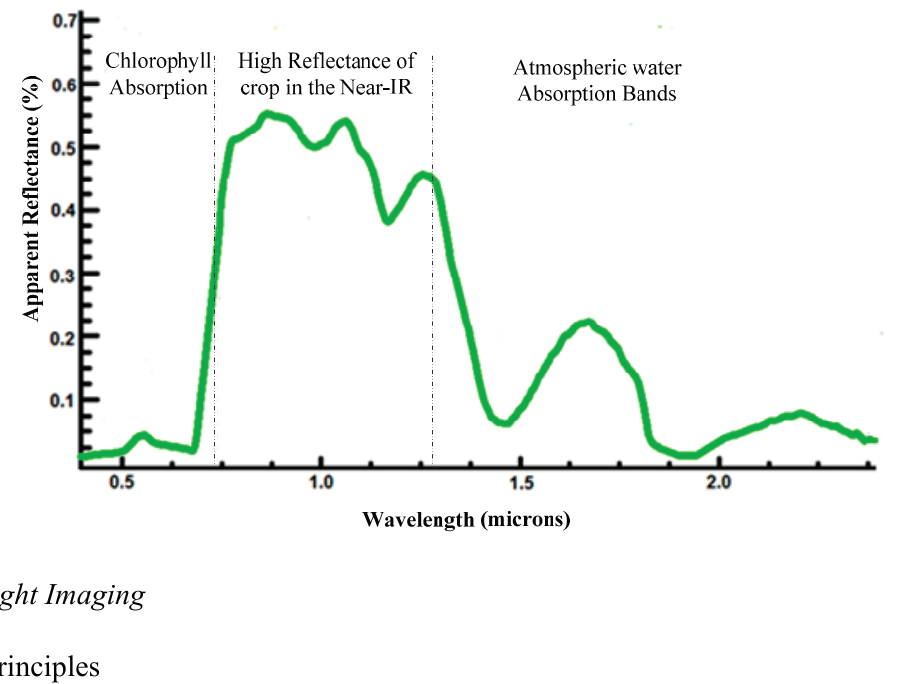
Figure 2. The typical reflectance spectra of crop at different wavebands